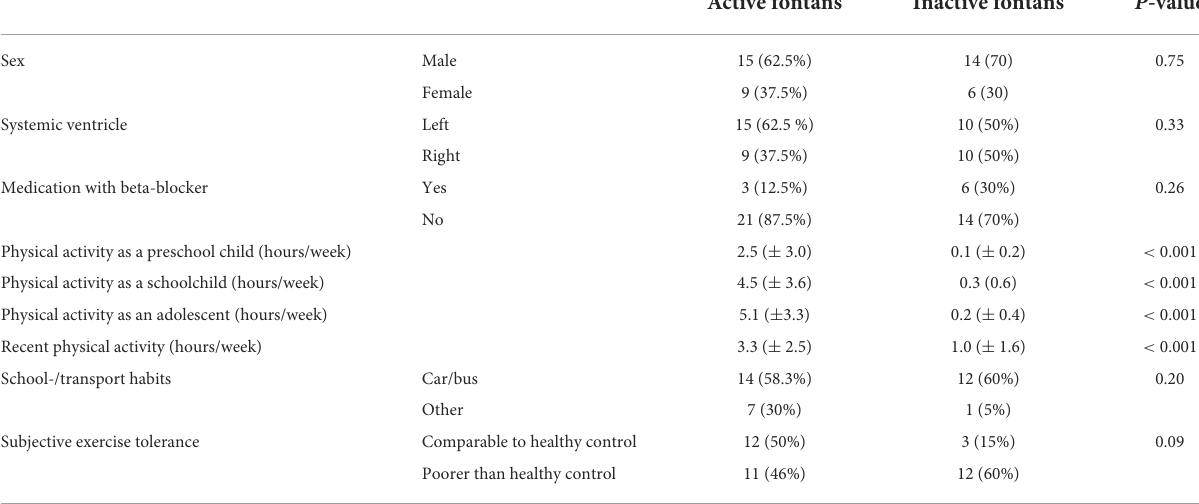
TABLE 1 Distribution of sex, systemic ventricle, medication with beta-blocker, school-/work transport habits and subjective exercise capacity as absolute values and in % in brackets.